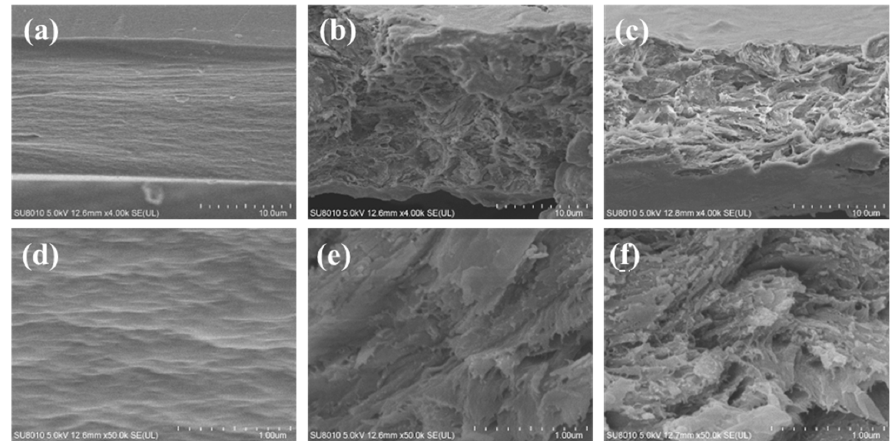
Figure 5. SEM images of cross section of membranes: ( a , d ) PI, ( b , e ) PI-50% ATP, ( c , f ) PI-60% ATP.